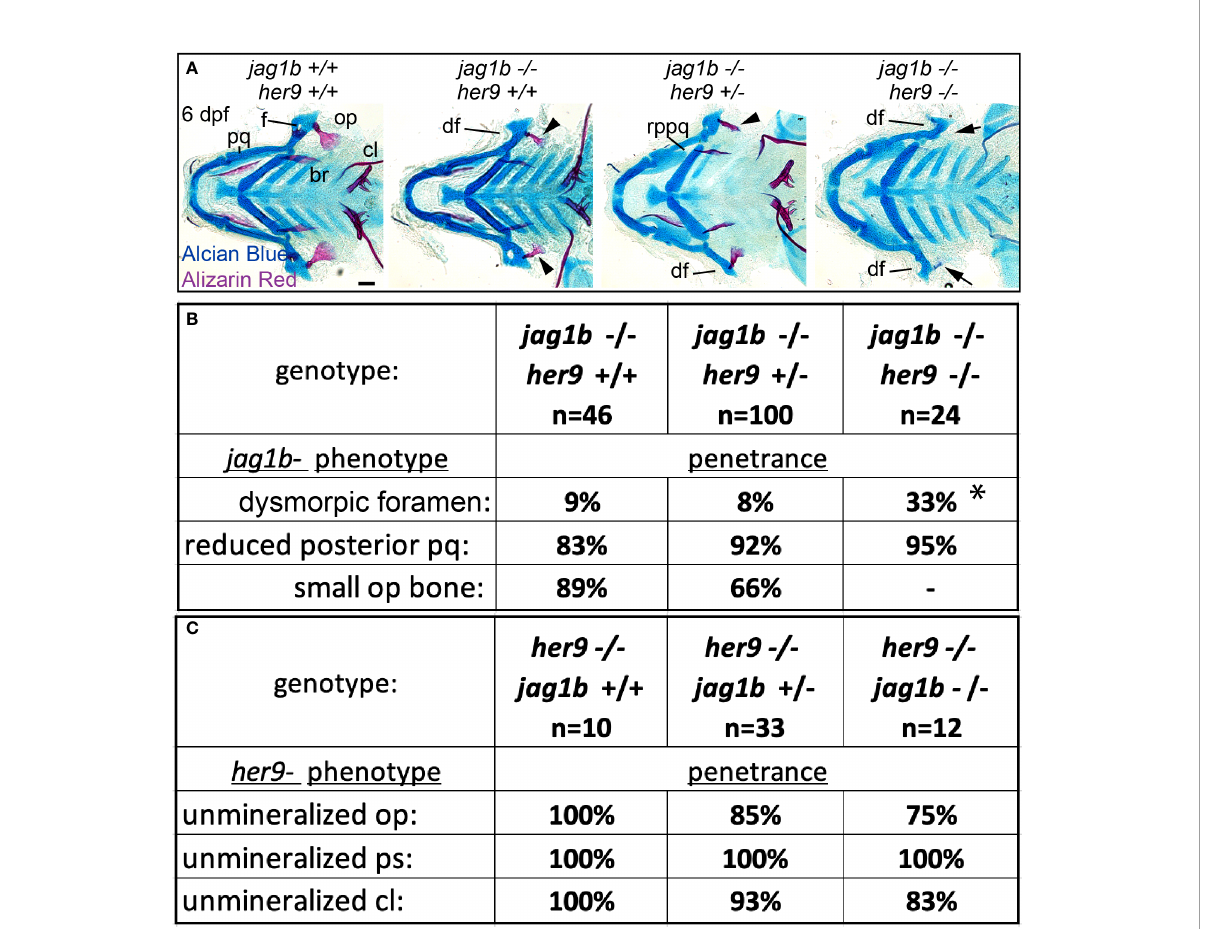
FIGURE 7 Mutations in her9 enhance jag1b mutant phenotypes. (A) jag1b ; her9 double heterozygotes were intercrossed and six days post fertilization (dpf) larvae were stained with Alcian Blue and Alizarin Red to label cartilage and bone. The individuals were then genotyped, the viscerocrania were dissected and fl at mounted then imaged. The following craniofacial skeletal elements are indicated in the wild-type individual: opercle bone (op), branchiostegal ray (br), cleithrum (cl), foramen (f) palatoquadrate (pq). The dysmorphic foramen (df) and reduced posterior pq (rppq) phenotypes are indicated, and the small op bone phenotype is indicated by an arrowhead. Arrows mark the opercle mineralization defect associated with her9 homozygous mutants. Poorly stained posterior arch derived cartilages and one missing entopterygoid bone in jag1b -/-; her9 +/- are staining and mounting artifacts in